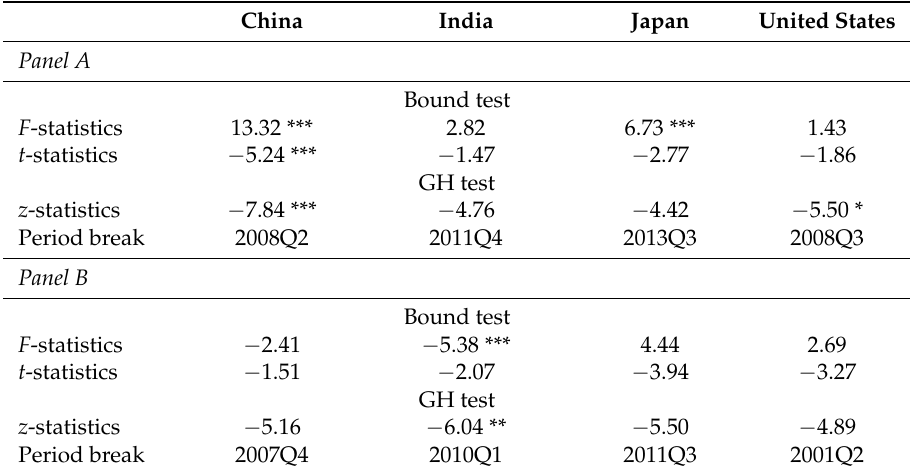
Table 5. Results of Cointegration tests.